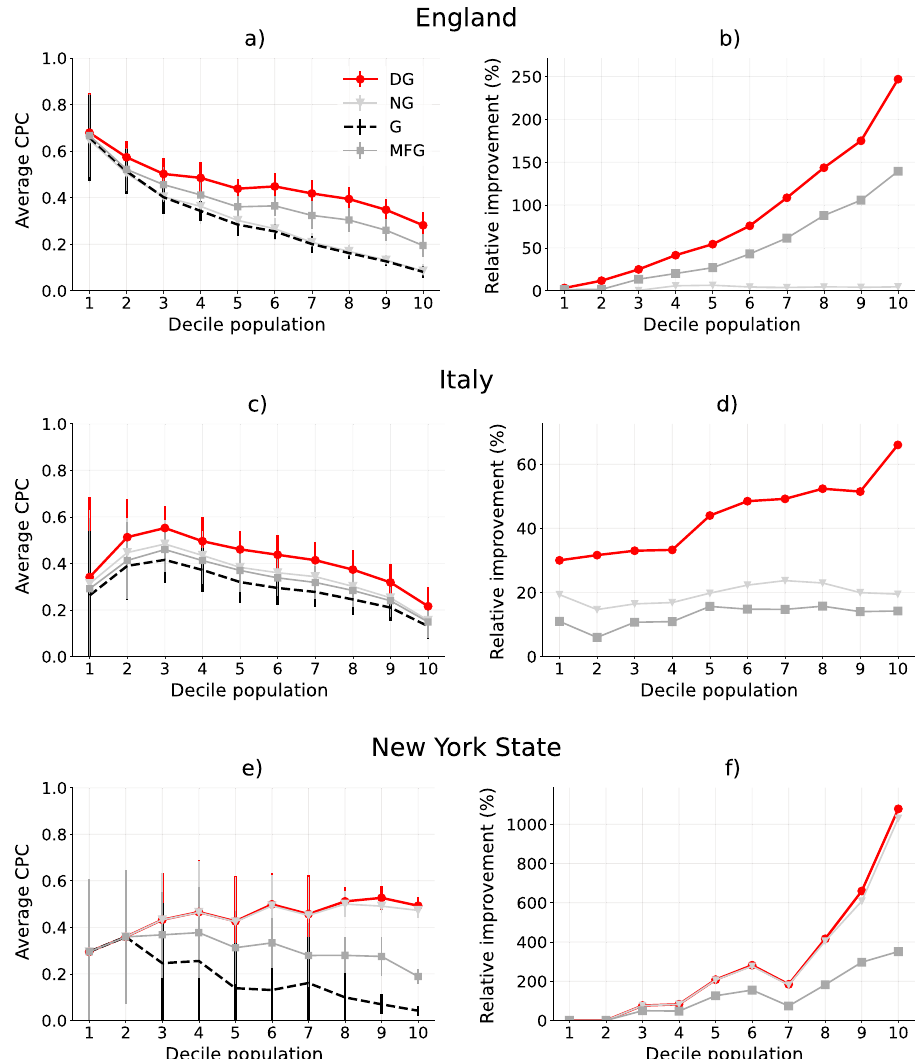
Fig. 4 Performance of the models. a , c , e Comparison of the performance in terms of Common Part of Commuters (CPC) of the gravity model (G, dashed line), Nonlinear Gravity (NG), Multi-Feature Gravity (MFG), and Deep Gravity (DG), varying the decile of the population and for regions of interest sizes of 25km for England ( a ), Italy ( c ) and New York State ( e ). Circles (DG), triangles (NG), and squares (MFG) indicate the average CPC for a decile. Error bars indicate the standard deviation of CPC of each decile. We run fi ve independent experiments in which we train the models on 50% of randomly chosen tiles, stratifying according to the population in the decile, corresponding to 84,491.63 Output Areas for England, 200,746.15 Census Areas for Italy and 2118.93 Census Tracts for New York State. The remaining 50% of the tiles are used to evaluate the performance of the models in terms of CPC. DG is by far the approach with the best average CPC, regardless of the decile of the population. b , d , f Relative improvement with respect to G of NG, MFG, and DG, varying the decile of the population and for regions of interest of 25 by 25 km 2 . The higher the population the higher is the improvement of DG with respect to G. For example, in England, for the last decile of the population, DG has an improvement of around 246% over G. Similarly, in Italy DG has a relative improvement of around 66%, while in New York State DG is around 1076% better than G in the last 10km (Supplementary Table 2): for example, in England it is about 220%, i.e., about 26% less than the improvement on the same decile for a region of interest size of 25 km.